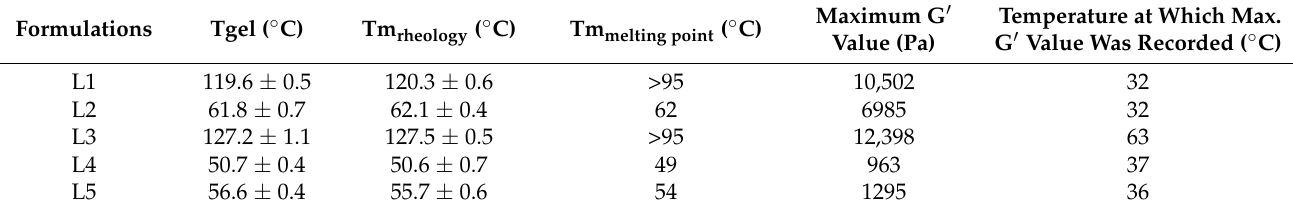
Table 1. Gelling (Tgel), melting (Tm) temperatures obtained with rheology (determined as reported) [16,42], melting point technique and maximum G′ recordings of lipstick formulations.